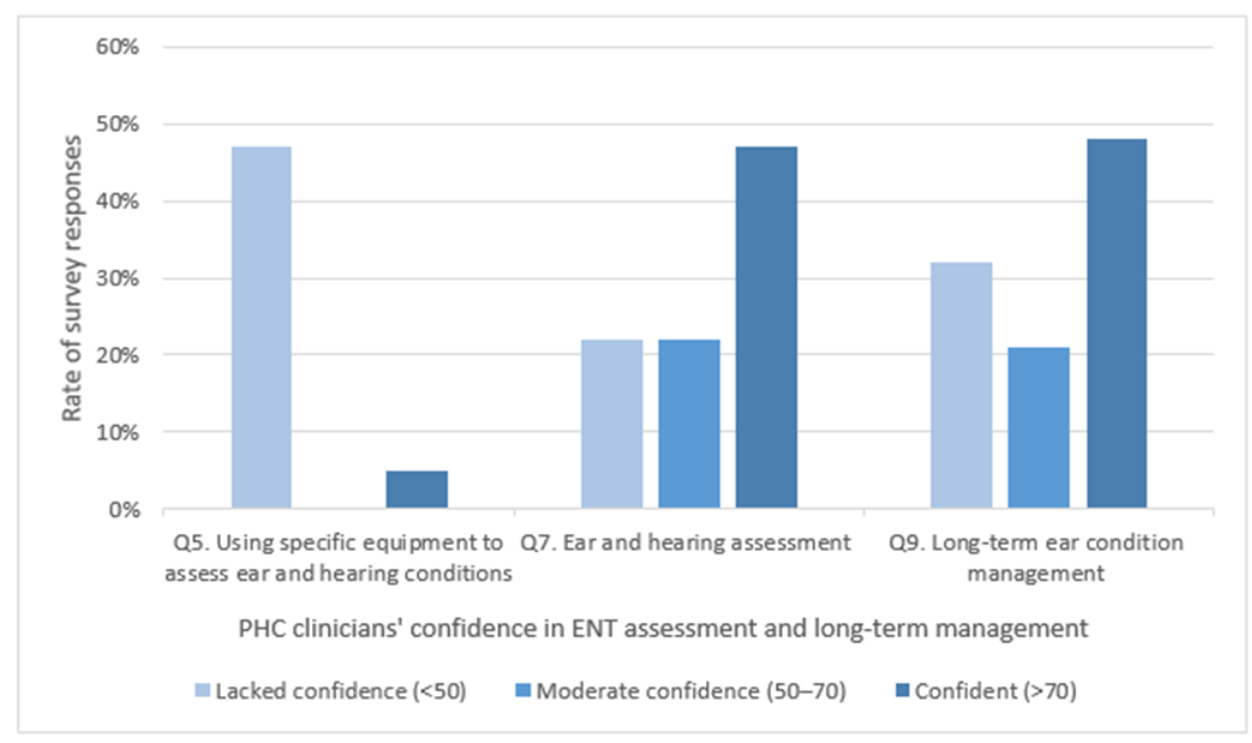
Figure 2. Clinician confidence at assessment, using ear-specific equipment and management of ear and hearing conditions.